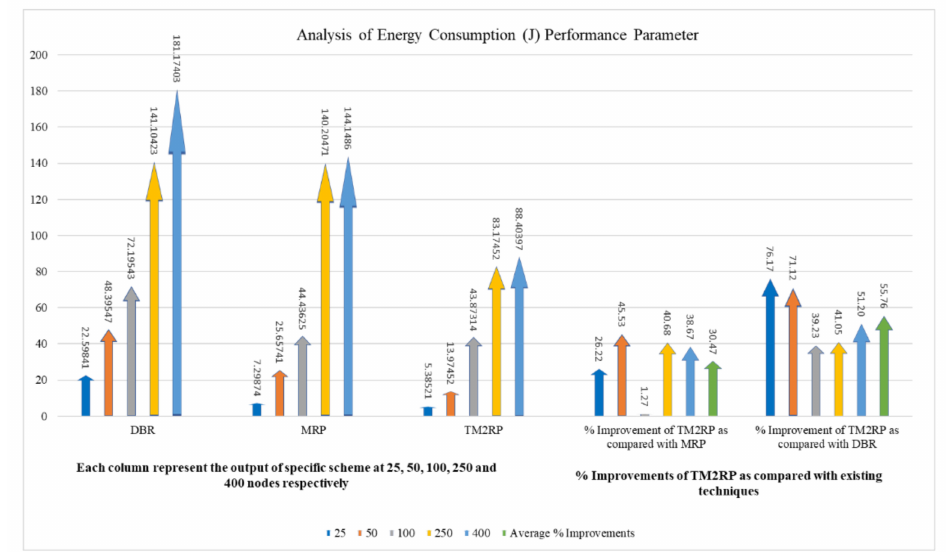
Figure 8. The statistical outcomes of the comparative protocols with regard to energy consumption.